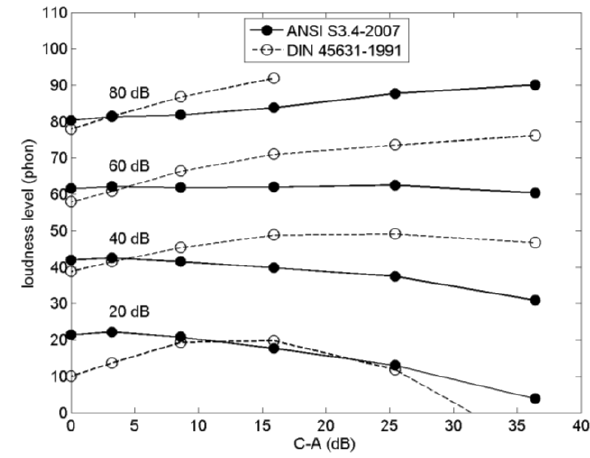
Figure 5. Loudness level as a function of C–A, calculated with ANSI S3.4-2007 and DIN 45631-1991 for the spectra shown in Figure 4, for A-weighted sound levels of 20, 40, 60, and 80